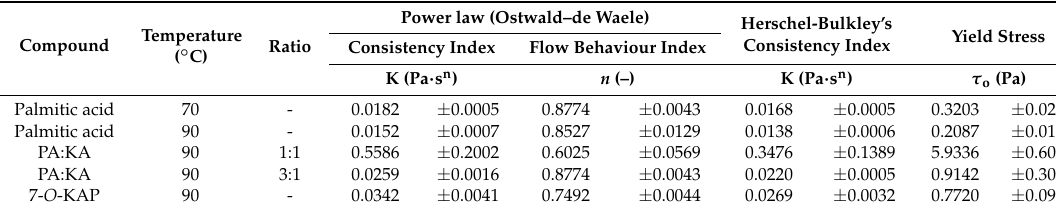
Table 3. The rheological behavior of fatty acid, reaction mixture (PA:KA) and purified 7- O -KAP. Data are presented as means ± S.E.M, n =